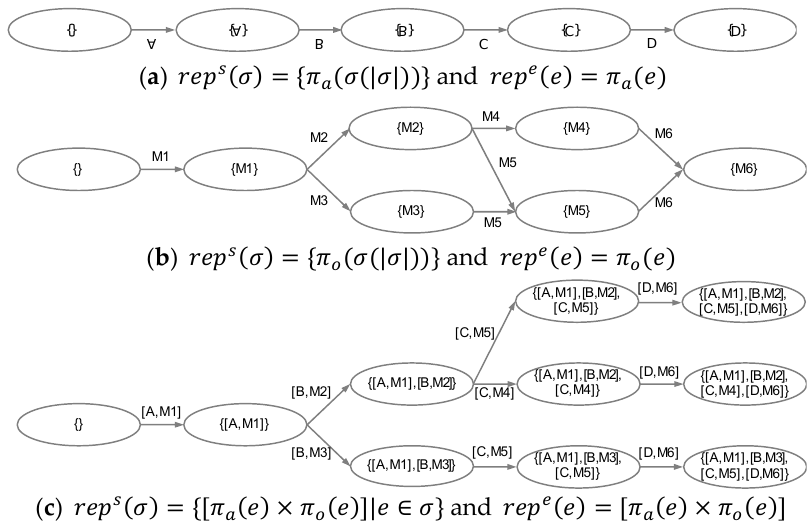
Figure 2. Examples of transition systems based on the event log in Table 1.